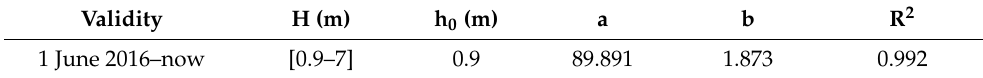
Table 4. Coefficient and application range of the rating curve equation of Niamey hydrometer.